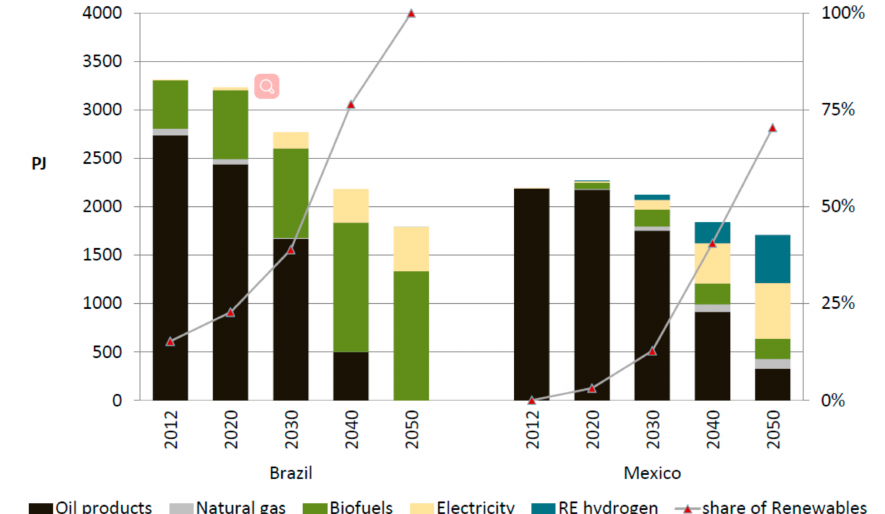
Figure 3. Fuel demand by source and renewable share in Brazil and Mexico for transport in